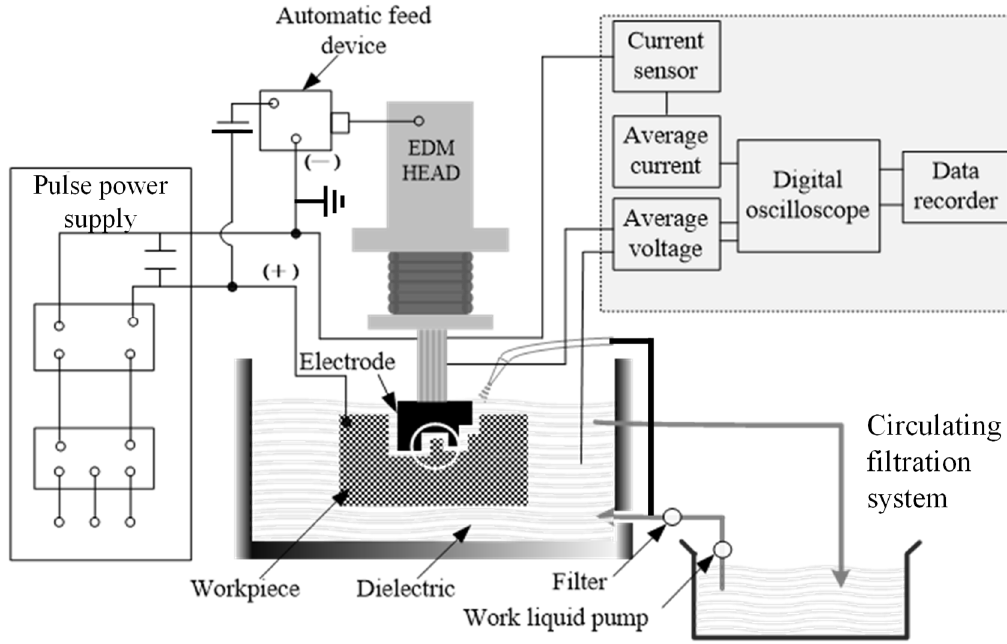
Figure 1. Schematic diagram of experimental system setup.